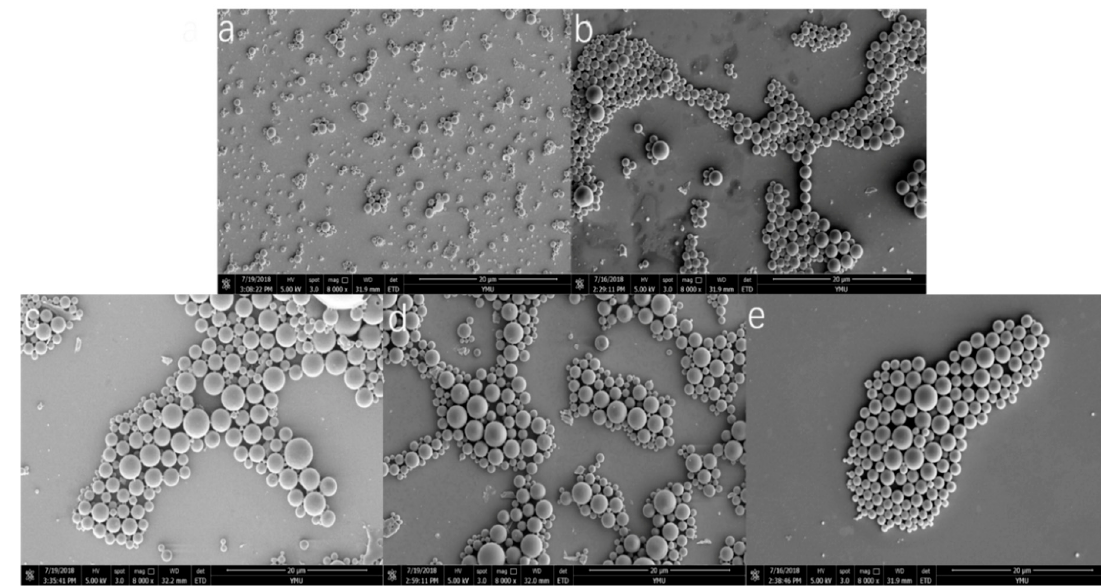
Figure 2. The scanning electron microscopy (SEM) morphology of Panax notoginseng saponins (PNS) microspheres. ( a ) mPEG 2k-PMA (1:9), ( b ) mPEG 5k- PMA (1:9), ( c ) mPEG 10k-PMA (1:9), ( d ) mPEG 10k-PMA (1:7), ( e ) mPEG 10k-PMA (1:5). The magnification of SEM image was 8000.